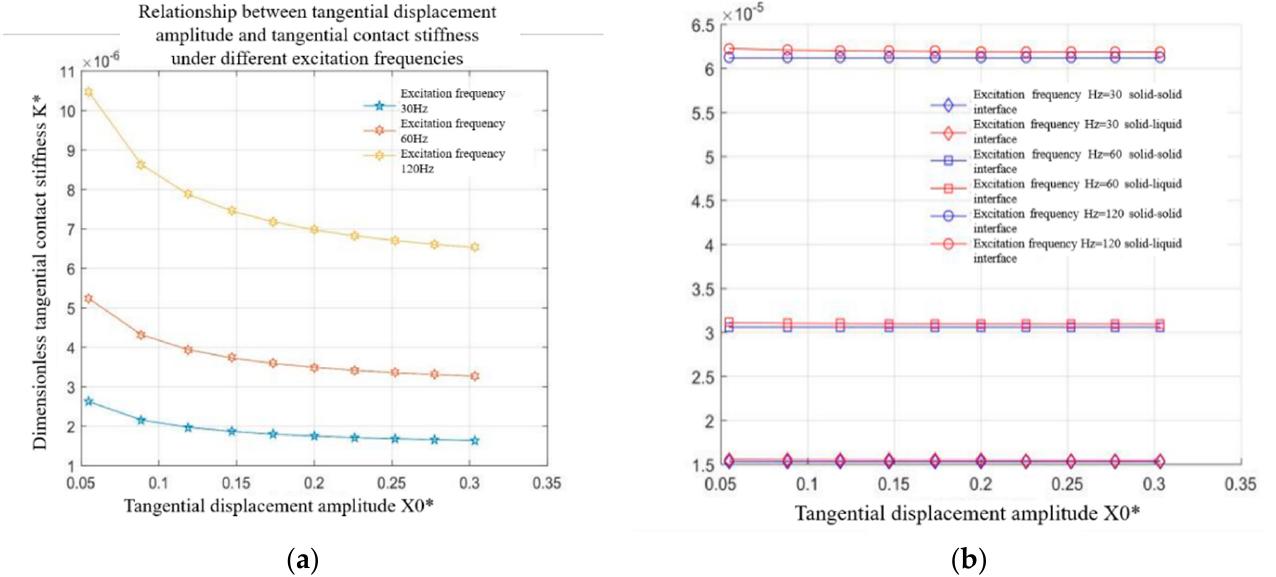
Figure 5. Relationship between the tangential contact stiffness and the tangential displacement amplitude under different excitation frequencies. ( a ) Fluid contact characteristics, ( b ) solid − solid and solid − liquid bonding face ratio.